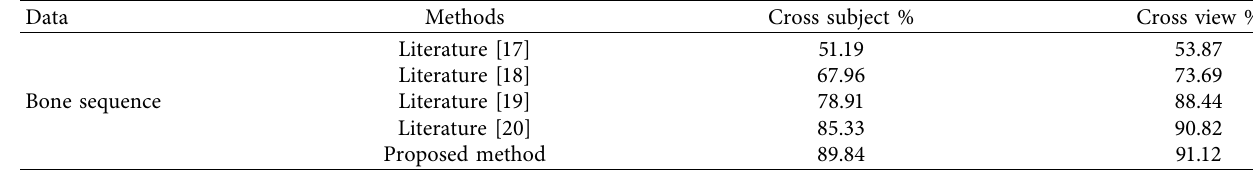
Table 1: Cross subject and cross view accuracy obtained by each algorithm for the dataset.